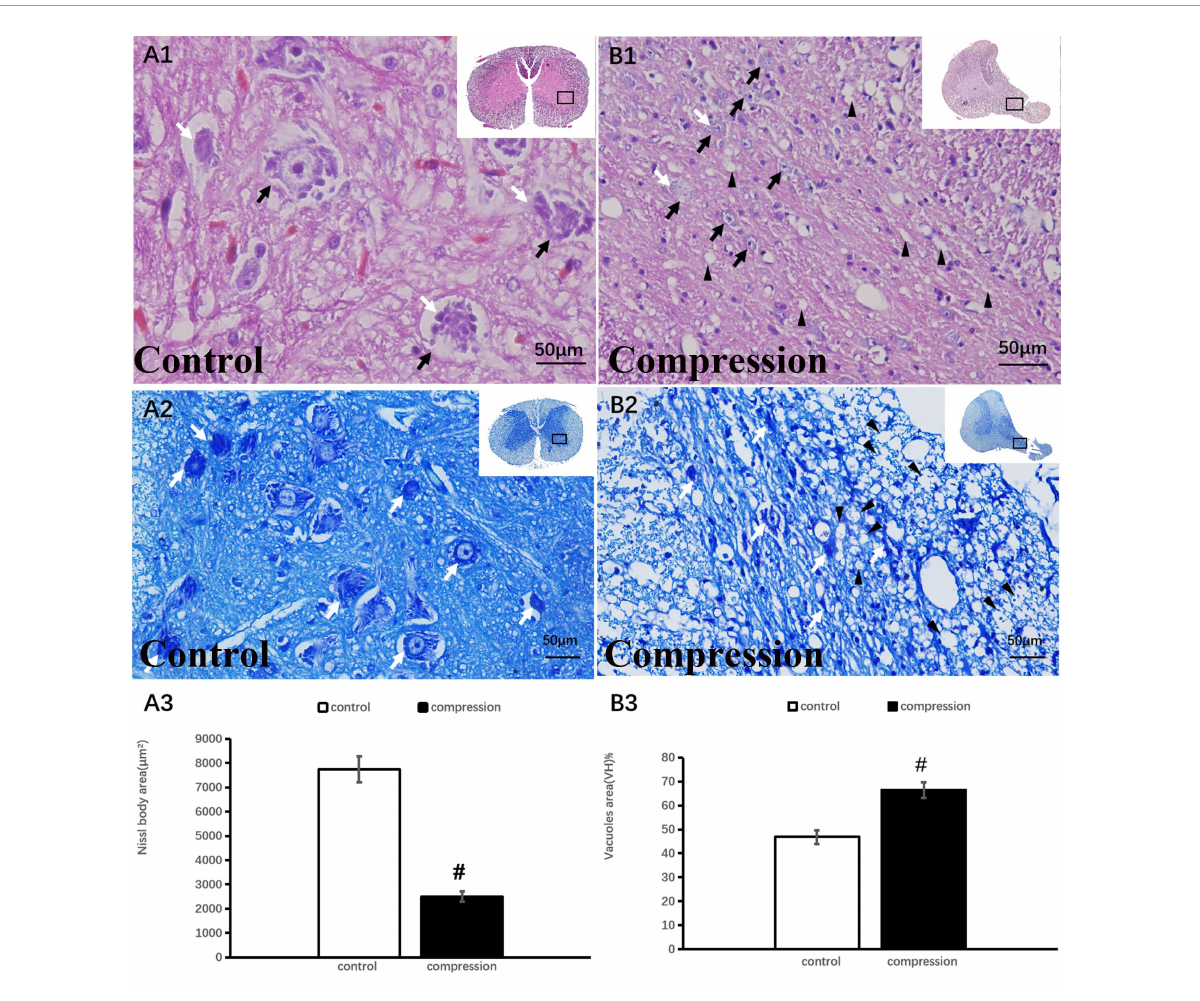
FIGURE3 Neuronal degeneration verified by HE and TB staining. (A1,A2) Numerous large motor neurons with rich Nissl body were identified in the ventral horn. (B1,B2) Loss of neuron and Nissl body with vacuolization in the ventral horn. Black arrow indicates large motor neuron, black arrowhead indicates vacuoles, and white arrow indicates Nissl body. A significant decline in Nissl body (A3) and increment in vacuoles (B3) in the compression group ( P < 0.05). “#” significant difference between CSM group and control group ( P < 0.05, n = 6 per